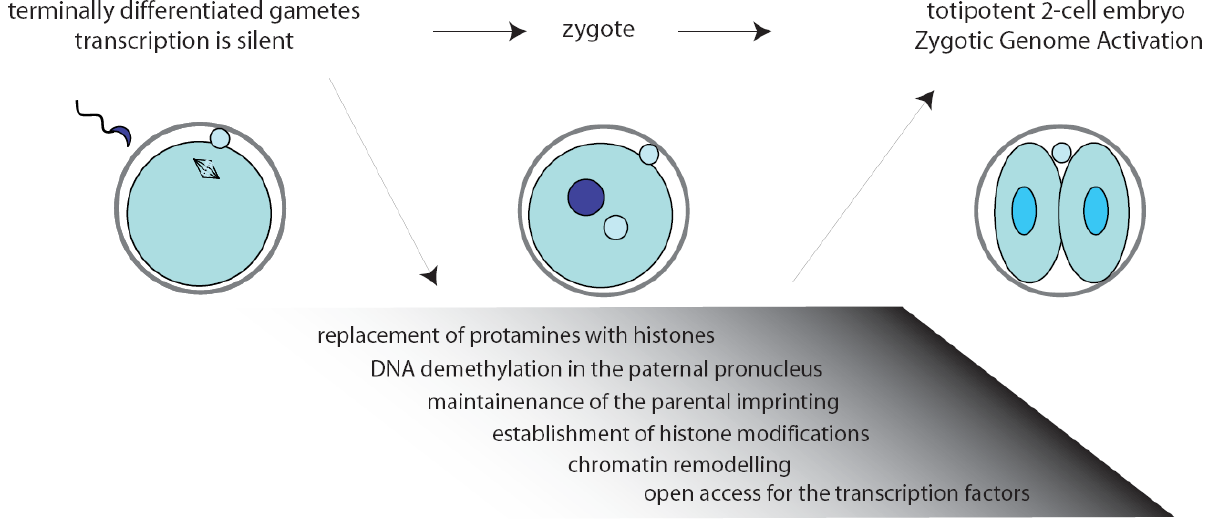
Figure 1. Schematic representation of the changes occurring in the chromatin of the zygote. The blastomeres of the two-cell embryo are the first truly totipotent cells. They originate from two transcriptionally repressed cells and acquire their peculiar capacity through the changes occurring in the zygote. The main necessary modifications concerning the remodeling of the chromatin of the two parental genomes are: erasure of the epigenetic marks that typify the genome of gametes; maintenance of epigenetic marks in the imprinted genes. This extensive reprogramming is carried out by the maternal factors stored in the